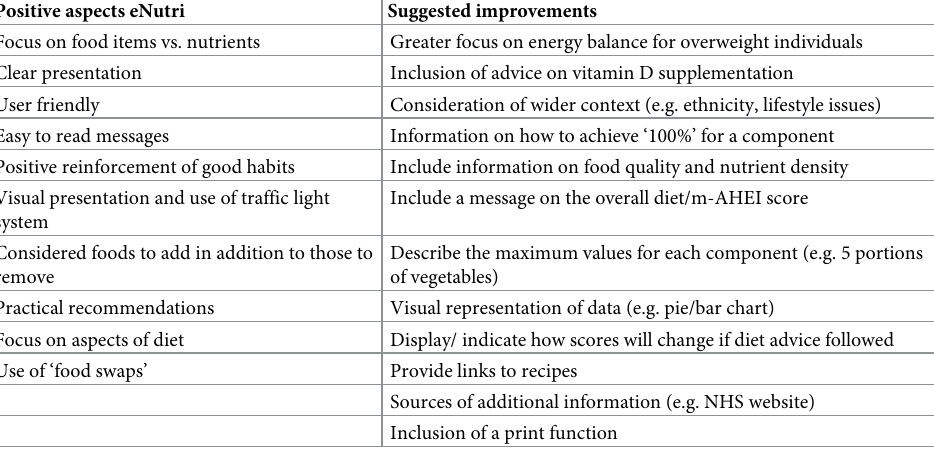
Table 5. Positive aspects and areas for improvement to the eNutri automated personalized nutrition advice iden- tified by nutrition professionals. Positive aspects